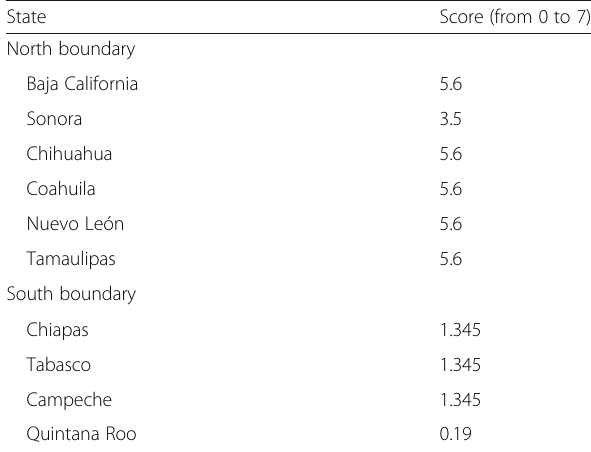
Table 2 Transboundary legal framework indicator for Mexican border states. Source: [46]